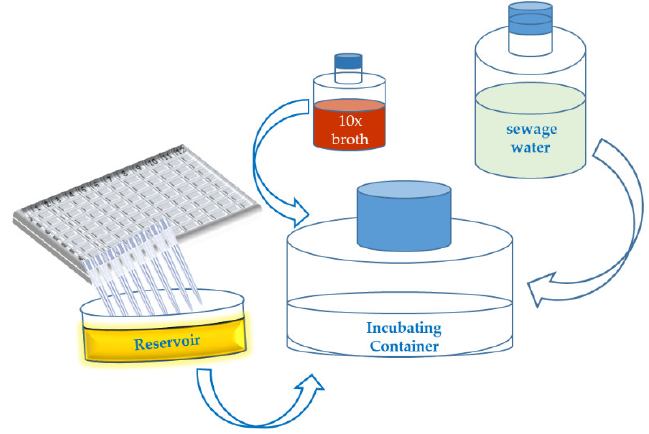
Figure A1. Diagram depicting the “phage isolation enrichment” method.